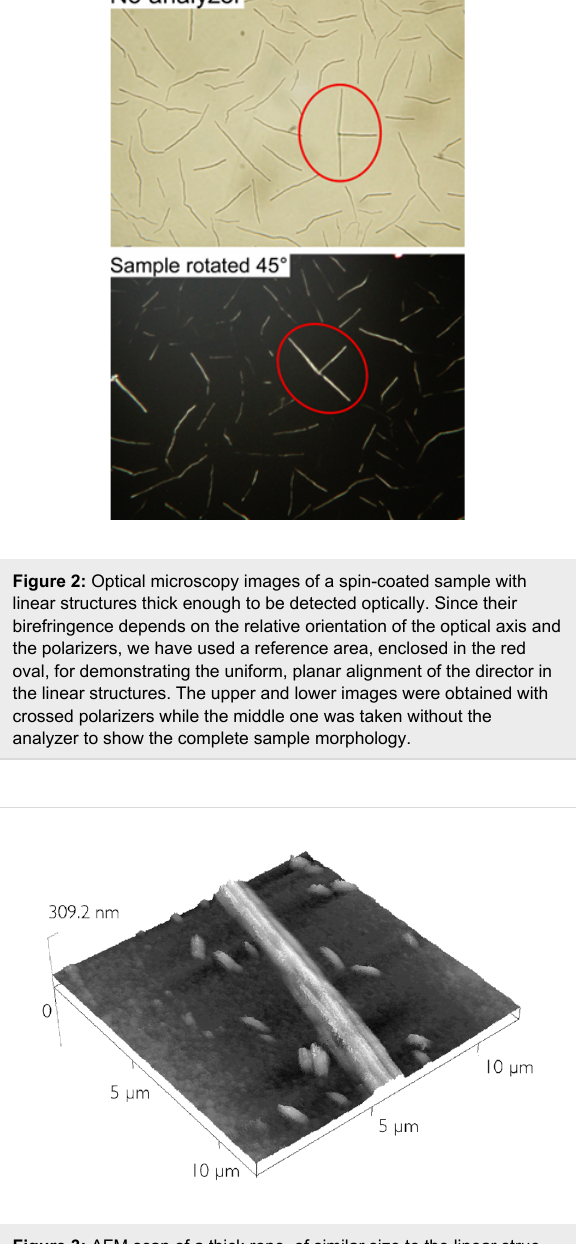
Figure 3: AFM scan of a thick rope, of similar size to the linear struc- tures observed by optical microscopy. AFM shows that they are actu- ally composed of several thinner fibers.